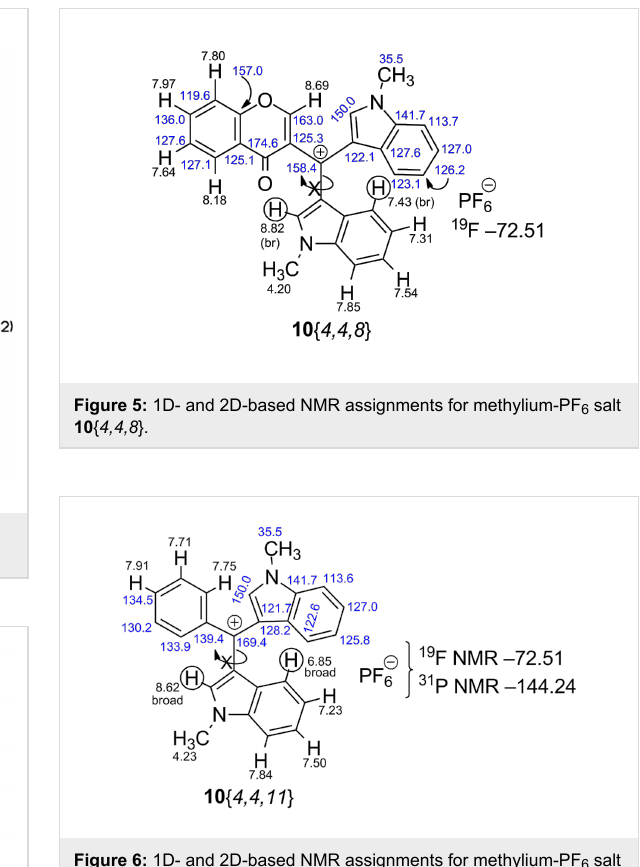
of giant (Ar 1 Ar 1 Ar 2 )CH and (Ar 1 Ar 2 Ar 3 )CH triads 8 and 9 , re- spectively, packed with up to three different pharmacophors in a single molecule. The ability to perform these reactions in ethanol and even in water, with no catalysts is noteworthy. Rep- resentative methylium salts generated by ionization with DDQ/ HPF 6 exhibited 1 H NMR signal broadening reflecting restricted rotation of the N -methylindole moieties at room